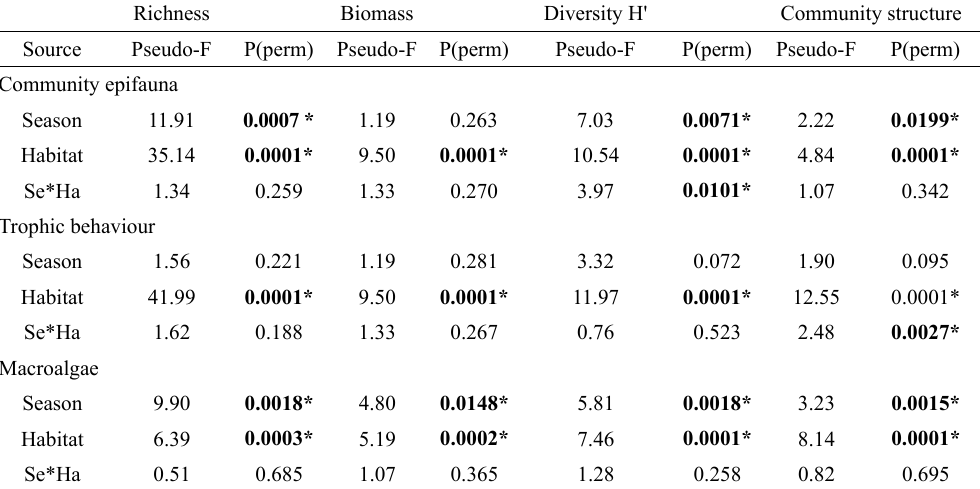
Table 2. – PERMANOVA outputs of the spatial-temporal variation of community epifauna, trophic groups and macroalgae at Tongoy Bay. Bold numbers correspond to a significant statistical difference at p≤0.05. Se is Season; Ha is Habitat.